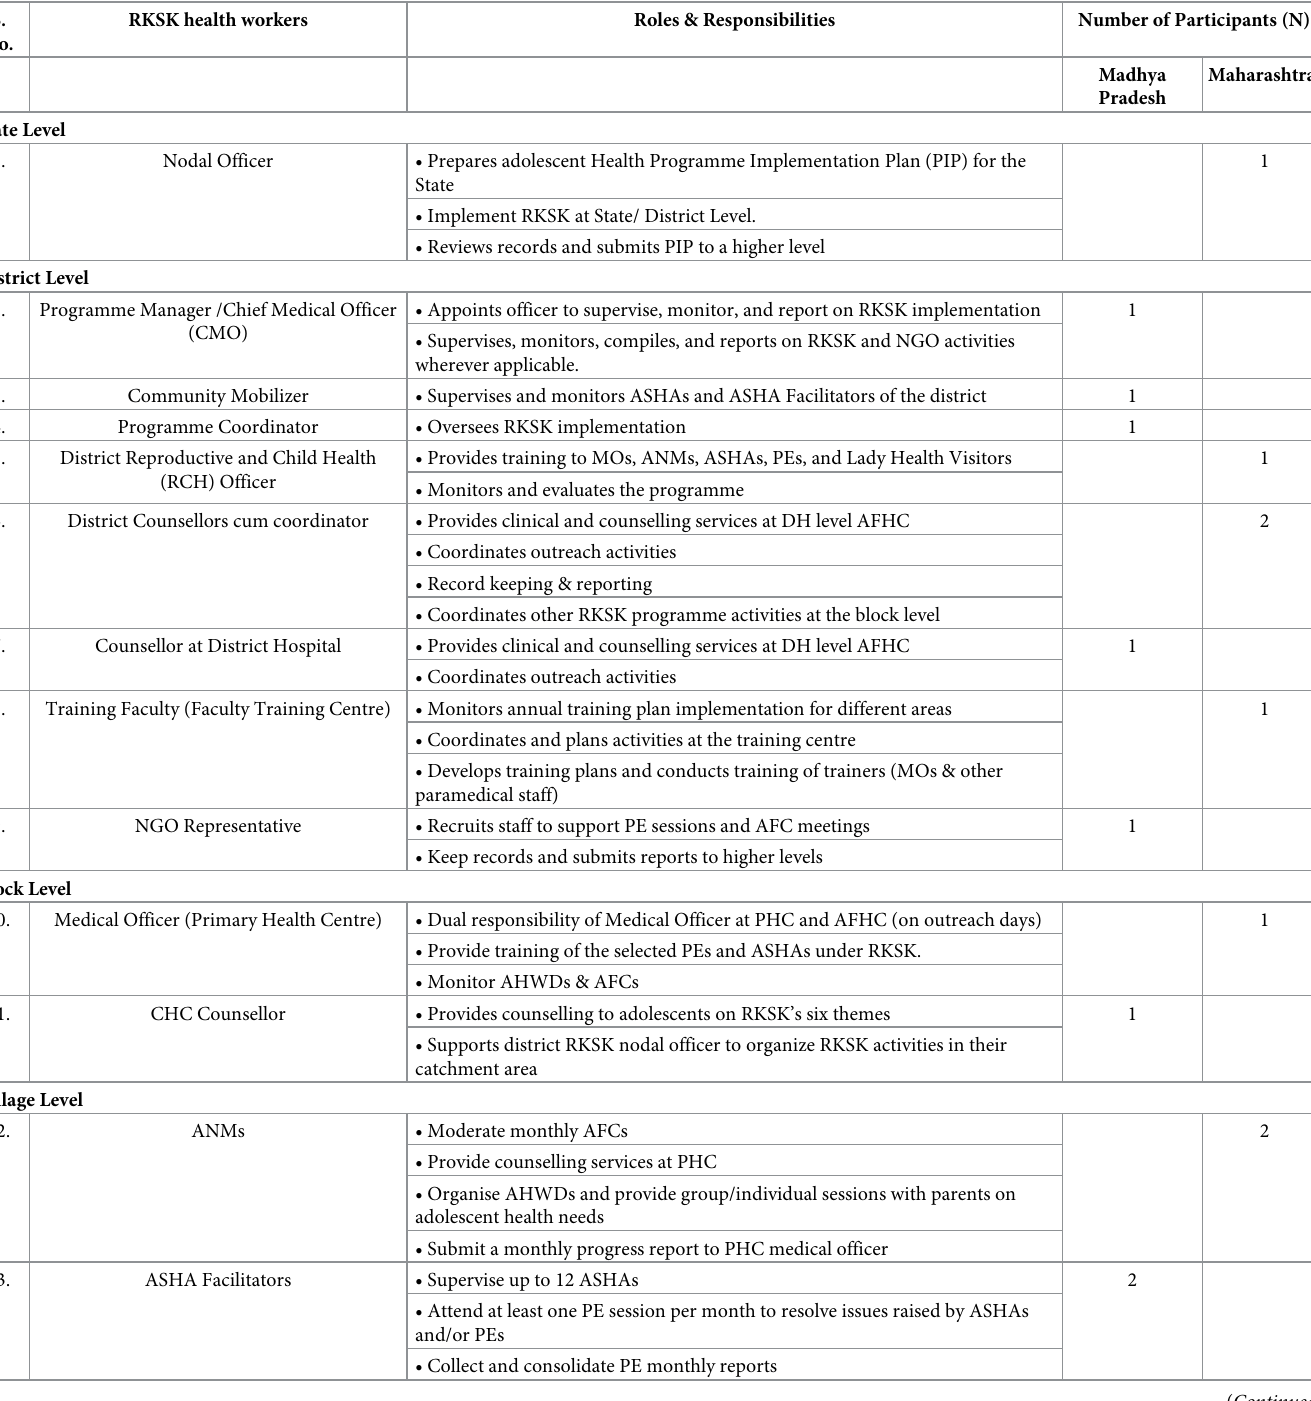
Table 2. Study participants & their roles and responsibilities (N =